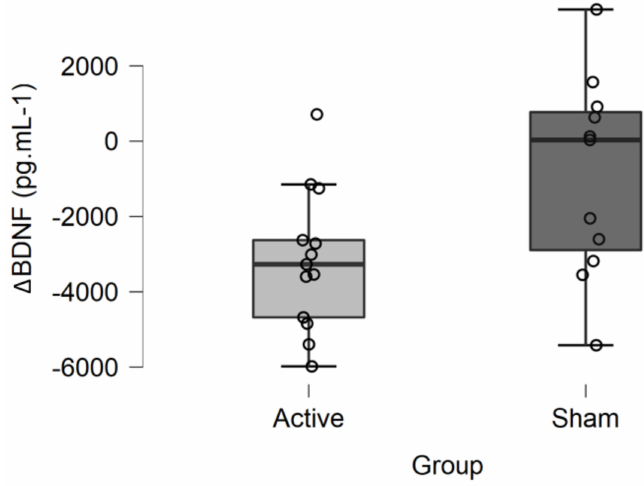
Figure 2. Changes in mBDNF levels ( ∆ BDNF) after active or sham tDCS. The decrease in serum mBDNF levels was significantly greater after active than after sham tDCS when adjusted for baseline mBDNF levels (F = 5.387; p = 0.030; η 2 =